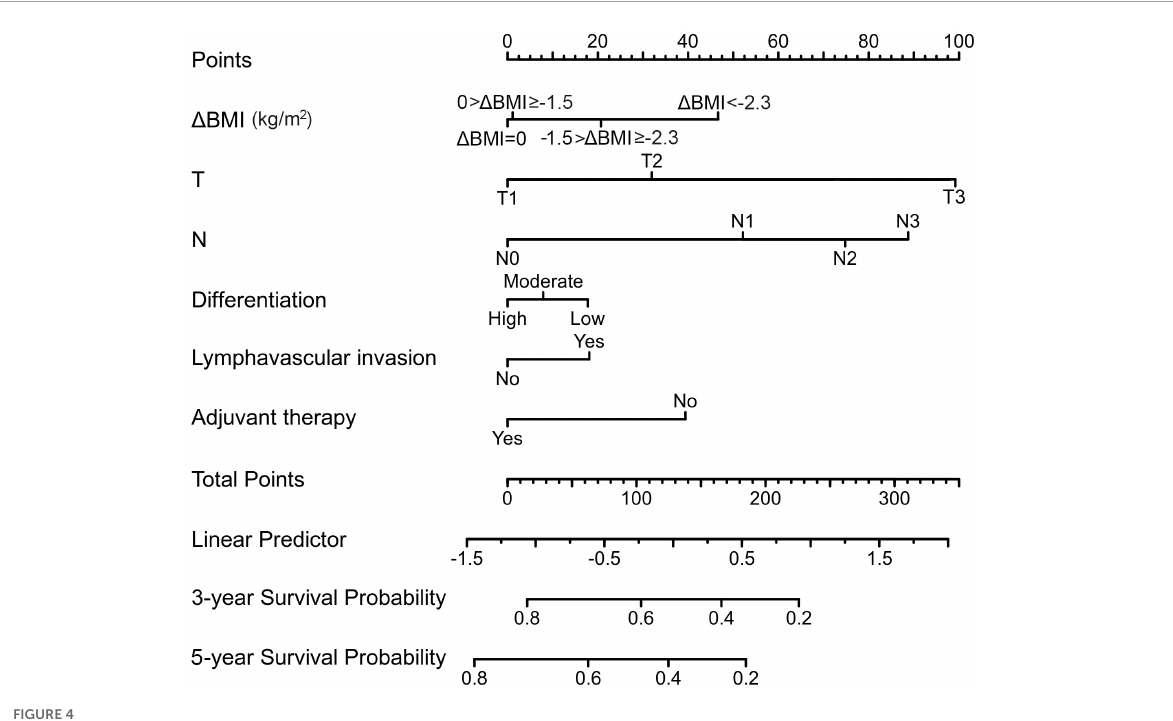
FIGURE4 A preoperative body mass index changes-based nomogram for predicting prognosis after curative resection of esophageal squamous cell carcinoma.